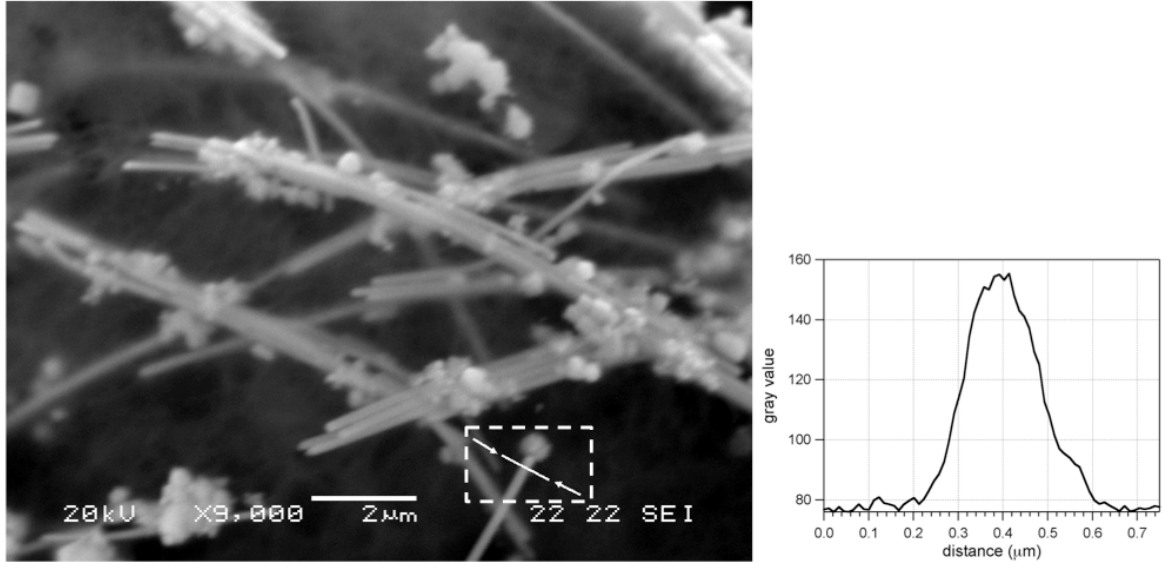
Figure 11. SEM micrograph of a PVA@AgNW film and plot profile of a silver nanowire (line scan within the white arrows).